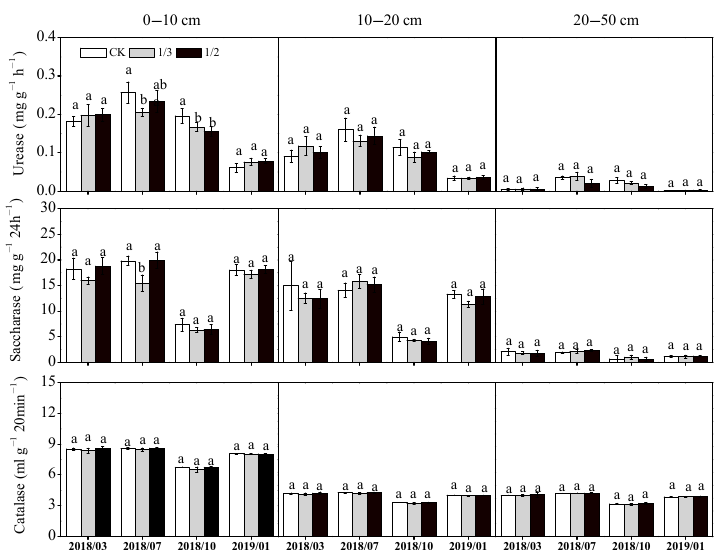
Figure 5. Dynamic change in soil enzyme activities in the poplar plantation after pruning treatments. Note: The same lowercase letter over two columns indicates no significant difference between pruning treatments at the same time point ( p > 0.05), while different lowercase letters indicate significant differences between pruning treatments at the same time point ( p < 0.05).